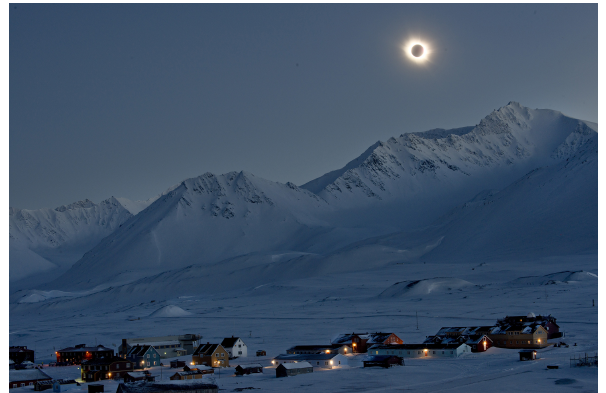
Figure 4. Ny-Ålesund global radiation (SW down ) on 20 March 2015, measured by a Kipp & Zonen pyranometer CMP22. The colour bar indicates the periods when the sun eleva- tion was above the horizontal line (yellow) or the instruments were shaded by mountains